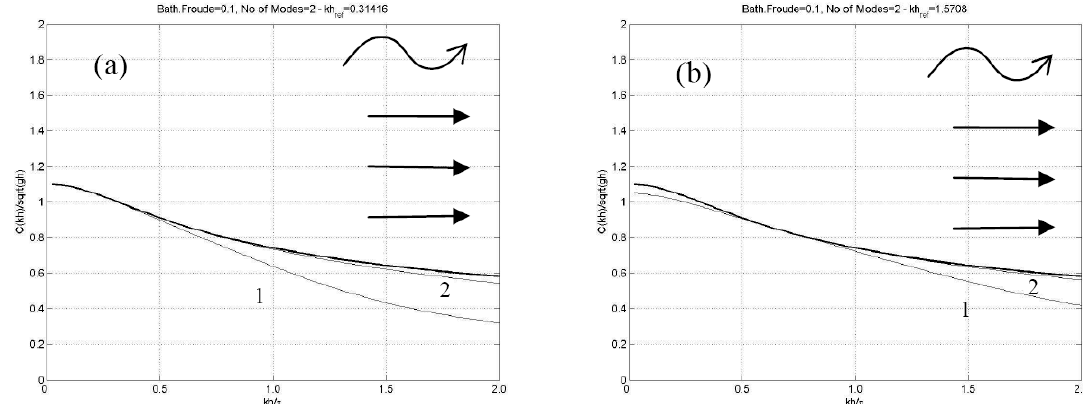
Figure 3. Dispersion characteristics of the linearized CMS in the case of waves and following parallel current F h = 0.1 in constant depth strip, using one term ( n = 0, indicated by 1), and two terms ( n = 0, 1, indicated by 2) in the local mode expansions; ( a ) µ 0 h = 0.1 π , ( b ) µ 0 h = 0.5 π .